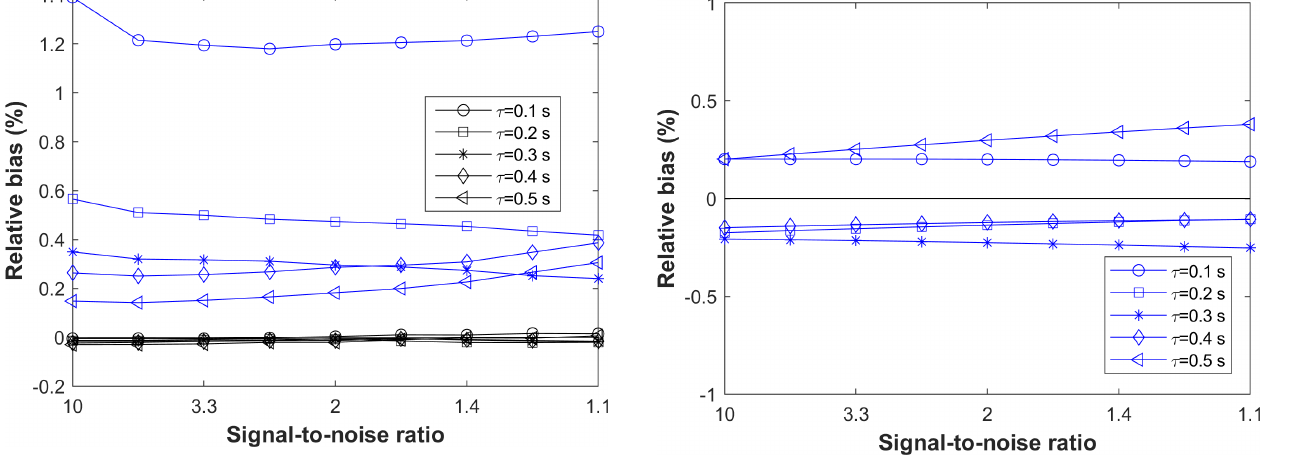
Figure 8. Relative biases of the cumulative fluxes derived with different PSA methods, i.e. PSA I07 (blue) and PSA A21 (black), compared with the reference flux as a function of SNR for differ- ent attenuation timescales (0.1–0.5s), calculated as, for example, − F REF )/F REF . 100 (F PSA I07